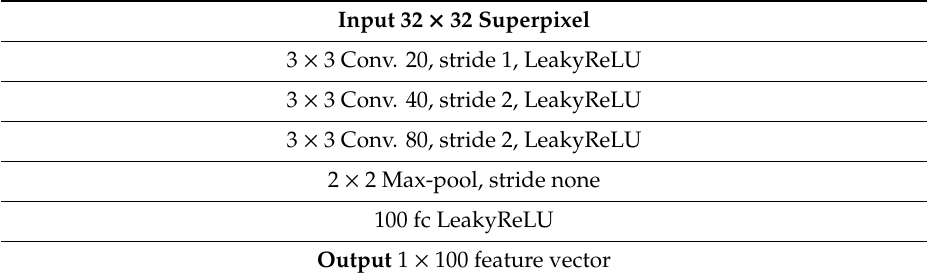
Table 2. The parameters of the CNN-based feature extraction